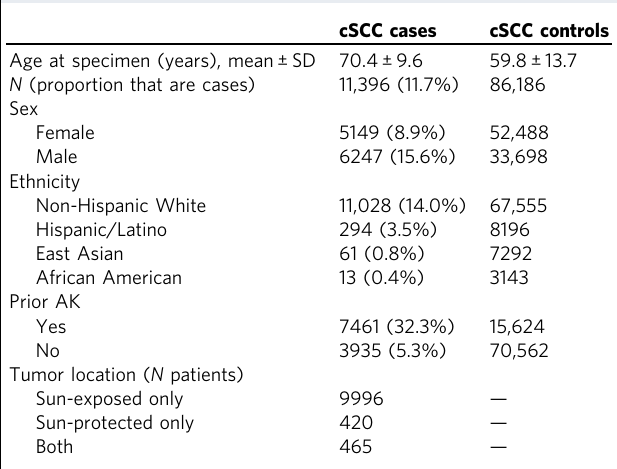
Table 1 Characteristics of the cSCC cases and controls from GERA